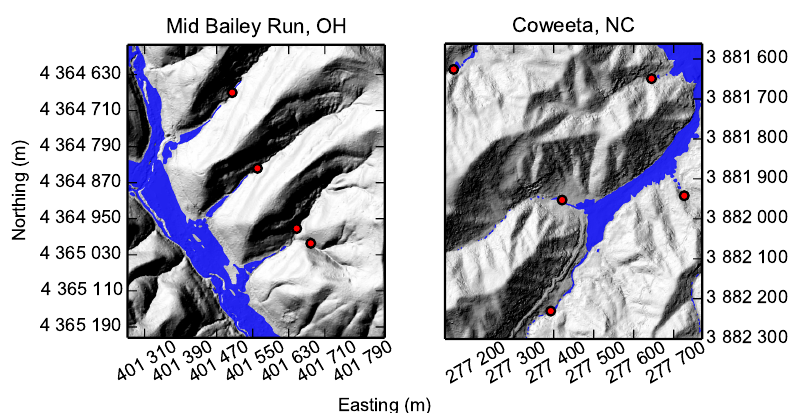
Figure 4. Shaded relief maps of Mid Bailey Run and Coweeta field sites showing the relationship between the predicted floodplain (blue) and the mapped floodplain initiation points (red). The UTM zone is 17 ◦